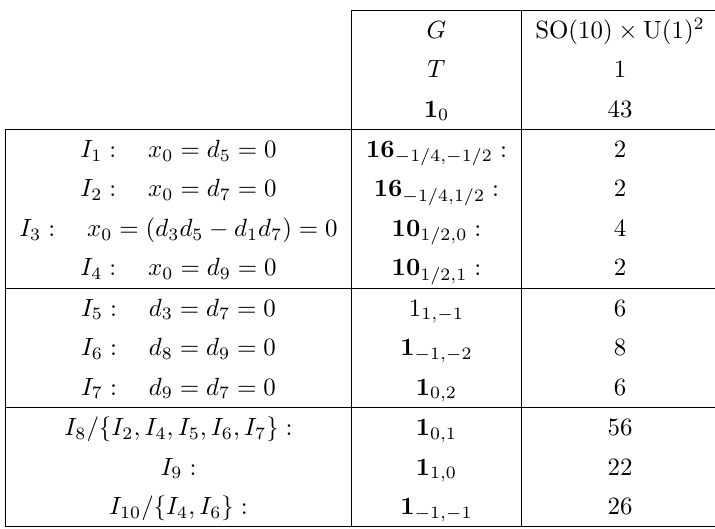
Table 1 . Summary of the 6D matter spectrum. We also give the respective codimension two loci and their multiplicities using eq. (3.26). The longer (quotient) ideals I 8 , 9 , 10 are given in eq. (3.27).